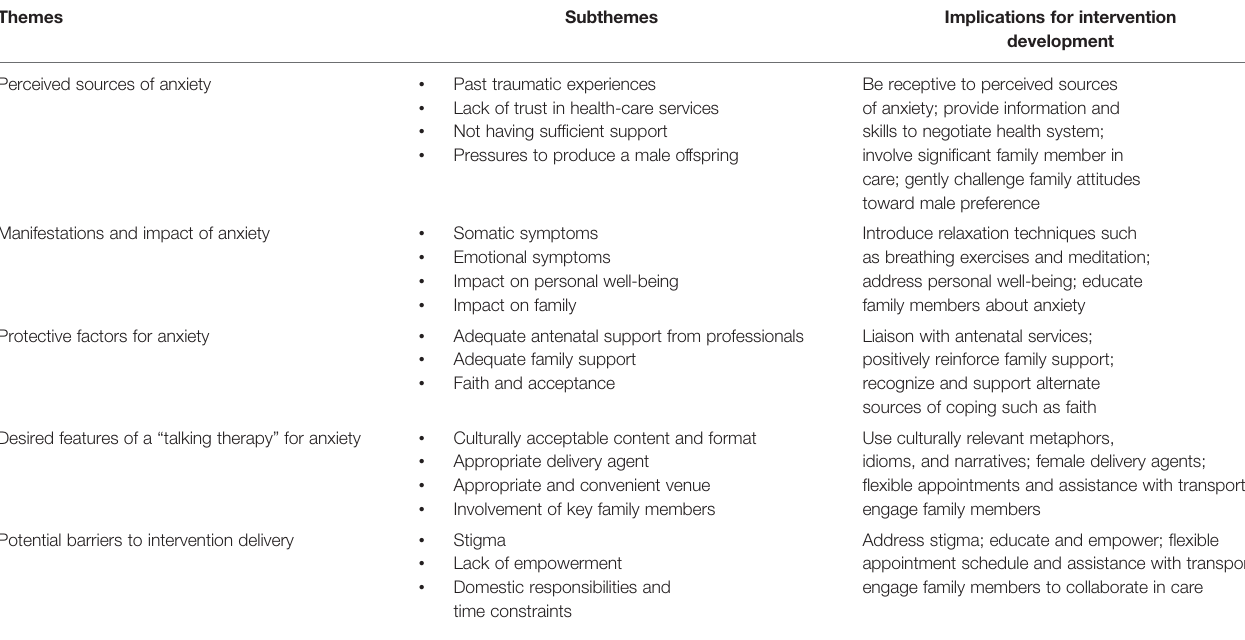
TABLE 2 | Summary of key themes, subthemes, and implications for intervention development.